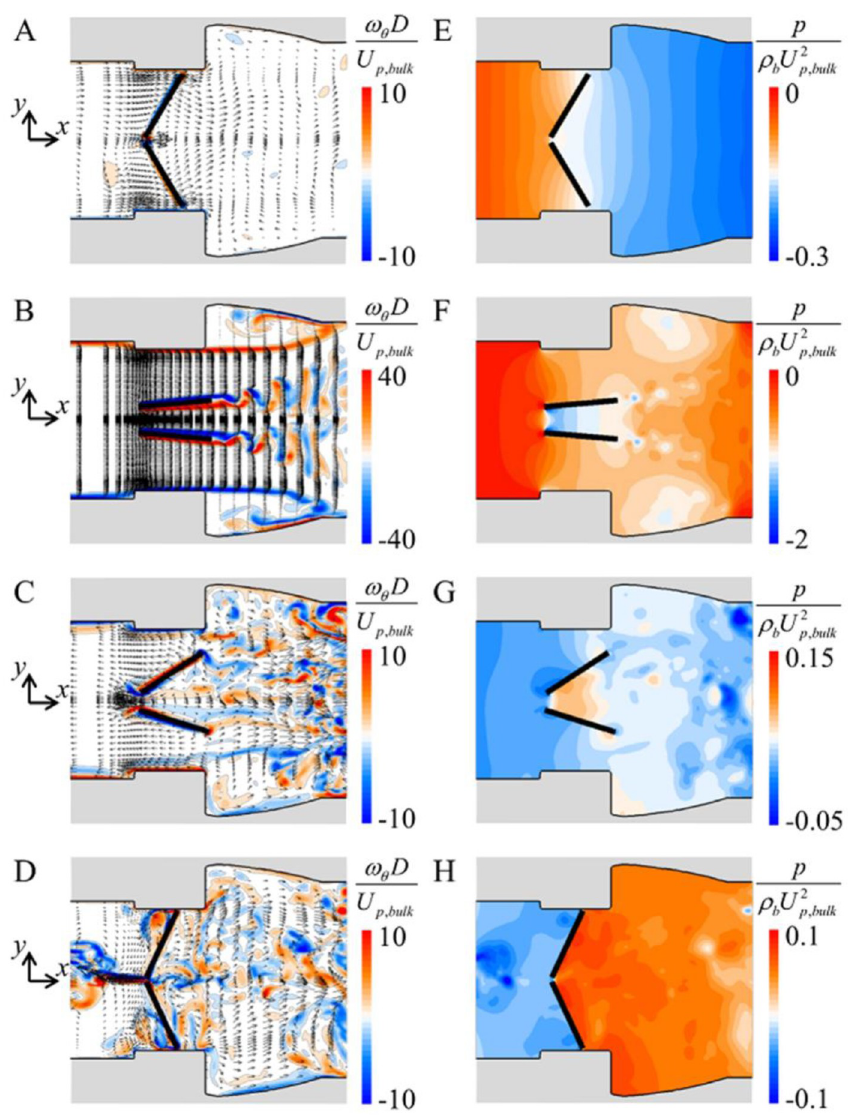
Fig 5. No pannus: contours of the instantaneous azimuthal vorticity and velocity vectors (A-D) and contours of the instantaneous pressure (E-H) during 10 th cycle (A and E: t / T = 9.28; B and F: t / T = 9.39; C and G: t / T = 9.63; D and H: t / T = 9.70) on the ( x - y ) plane ( θ = 90˚). Here, different contour levels are selected to better represent the flow features.